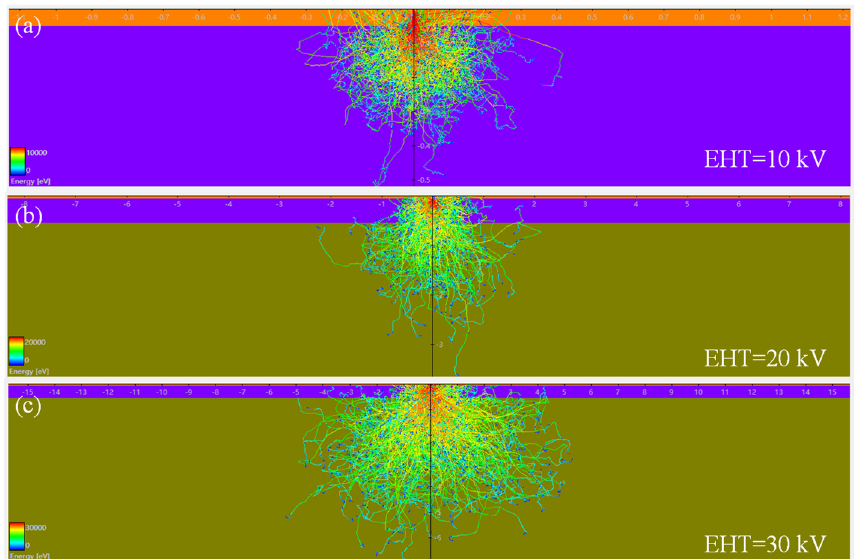
Figure 2. Monte Carlo simulations of the electron energy distribution into the PMMA film with an e-beam energy of 10, 20 and 30 keV. ( a ) EHT = 10 kV; ( b ) EHT = 20 kV; ( c ) EHT = 30 kV. The higher- energy electrons are highlighted in red, the lower-energy electrons in yellow and green.